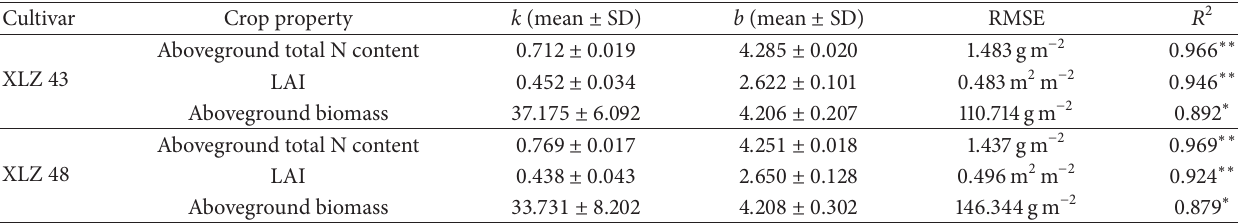
Table 3: Exponential equations showing the relationships between canopy cover and the three crop properties of two cotton cultivars in experiment